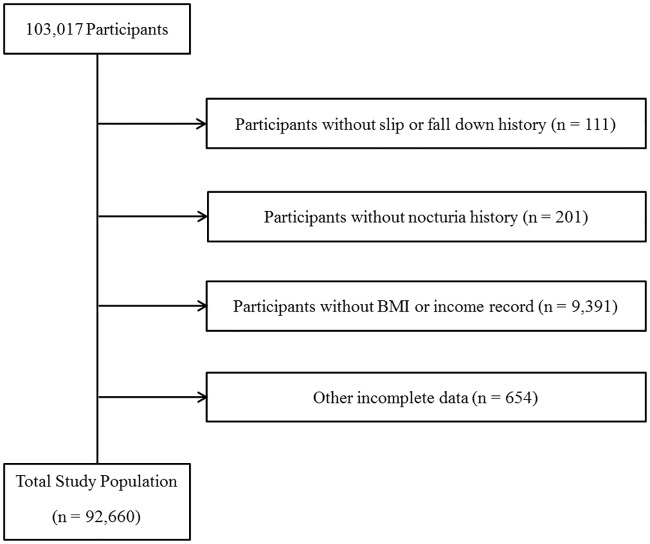
A schematic illustration of the participant selection for the present study.Among a total of 103,017 participants, the participants without a history of fall down (n = 111) or nocturia (201), BMI or income records (9,391) and other incomplete data (654) were excluded. The data for the 92,660 participants from whom complete data were obtained were analysed.